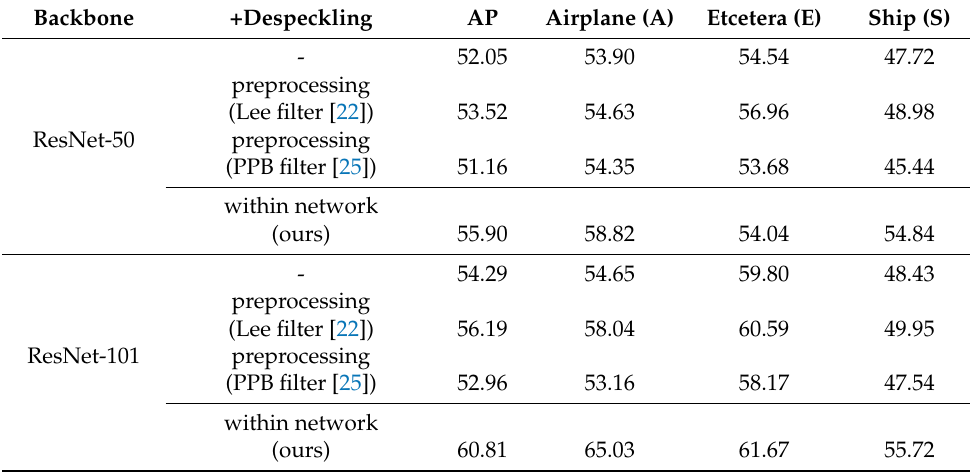
Table 2. Comparison of detection performance on our constructed dataset with TerraSAR-X and COSMO-SkyMed images. By incorporating region proposals from denoised SAR images within detection network, our model shows significant improvement in AP. The entries with the best APs for each object category are highlight in bold.